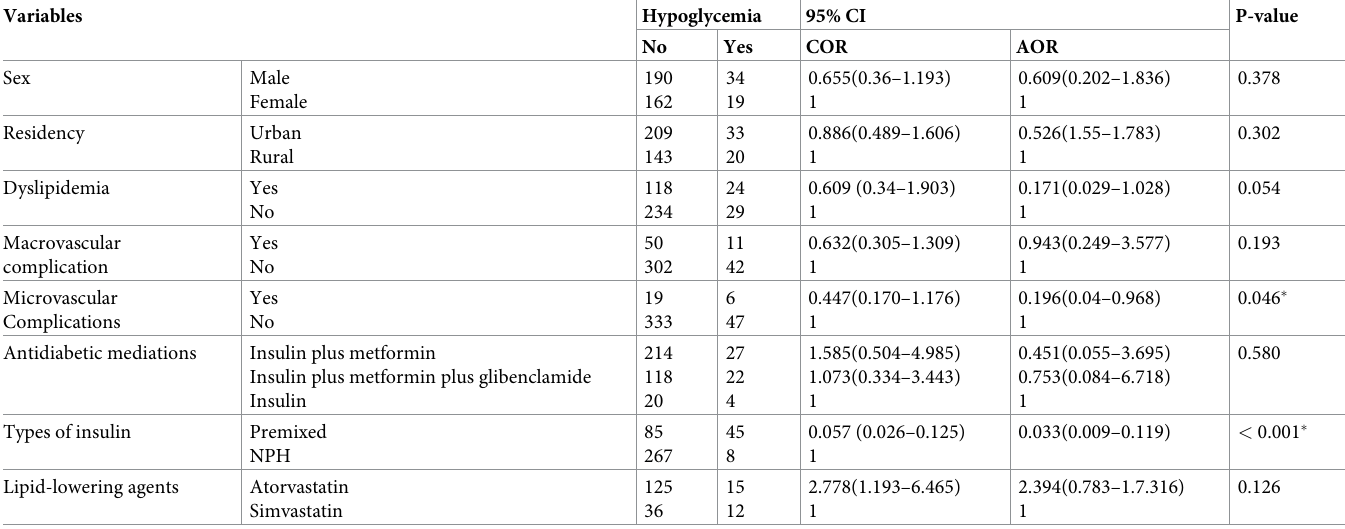
AOR, adjusted odds ratio; COR, crude odds ratio; CI, confidence interval � indicated p value <